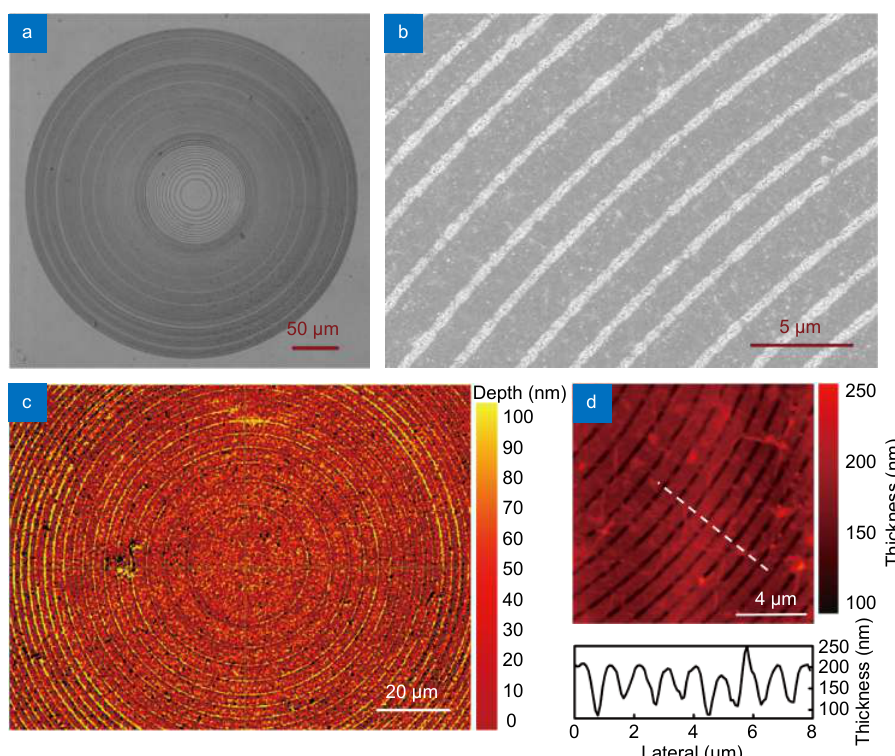
Fig. 2 | Characterization of GO metalens. ( a ) Optical image of GO metalens taken by an optical microscope with an objective of ×20, NA =0.5, the scale bar is 50 μm. ( b ) The zoom-in image of the up-right corner taken by an SEM, in which the scale bar is 5 μm. ( c ) Large-scale surface morphology of GO metalens measured by a 3D optical profiler. The scale bar is 20 μm. ( d ) The zoom-in image of the lower-right corner taken by an AFM. The scale bar is 4